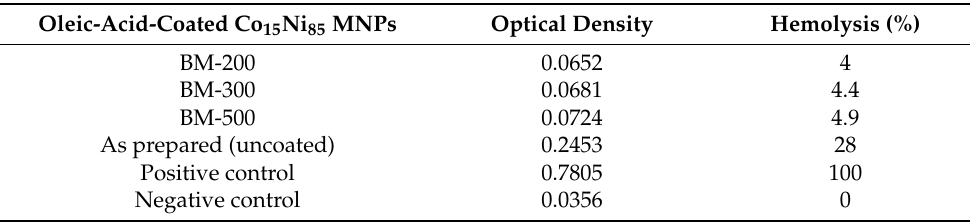
Table 1. Hemolysis activities of bare (as prepared) and oleic-acid-coated Co 15 Ni 85 NPs milled for 100, 200, 300, and 500 min at 1425